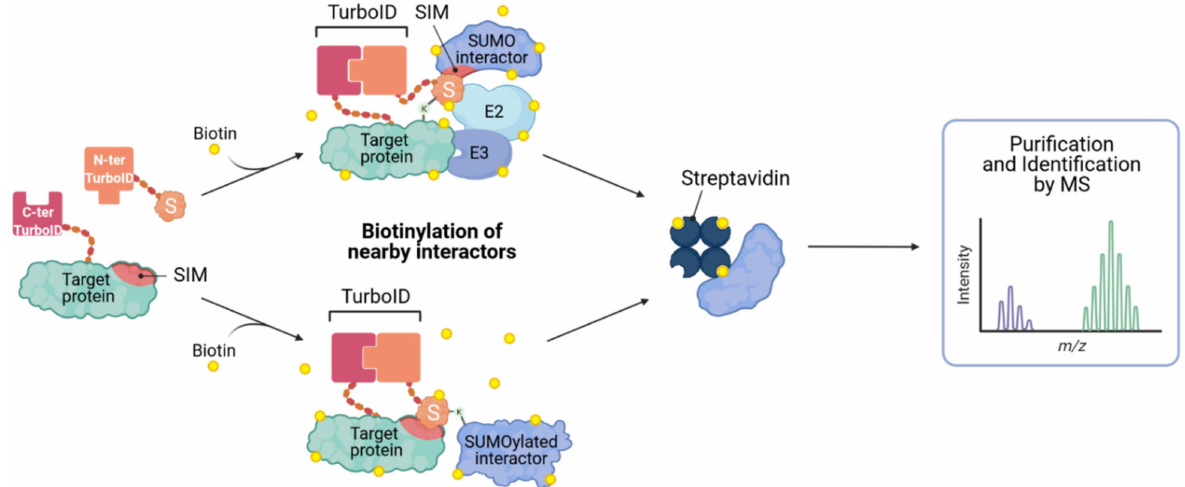
Figure 5. Identification of SUMO-interacting proteins by SUMO-ID. The N-terminal Split-TurboID construct is fused to the SUMO of interest, and the C-terminal fragment is fused to a potentially SUMOylated (or SIM-containing) target. Target SUMOylation, or SUMO-SIM interaction, results in reconstitution of the Split-TurboID and permits biotin labeling of proximal proteins. Biotinylated proteins can then be purified on streptavidin matrices and analyzed by mass spectrometry (MS). Concept developed in